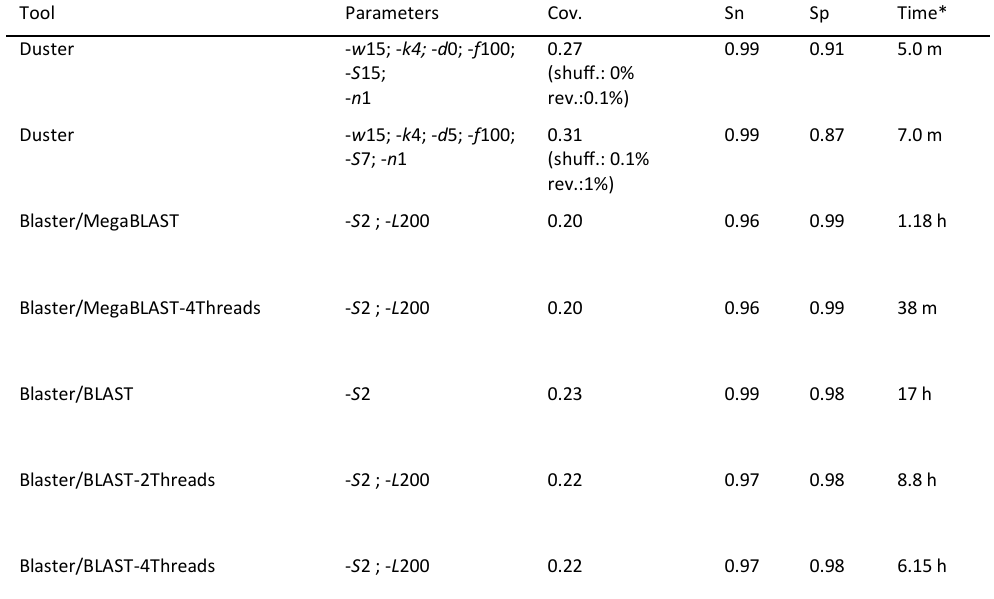
Table 1: Comparison of tool performances with TE sequences from the official TAIR A. thaliana TE annotation. *computed on a Linux workstation with Intel Xeon® CPU E3-1270 v3 @ 3.50 GHz x 8 and 15.5 Go of